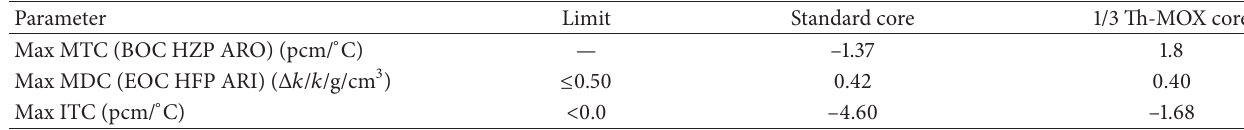
Table 2: The reactivity feedback MTC, MDC, and ITC.